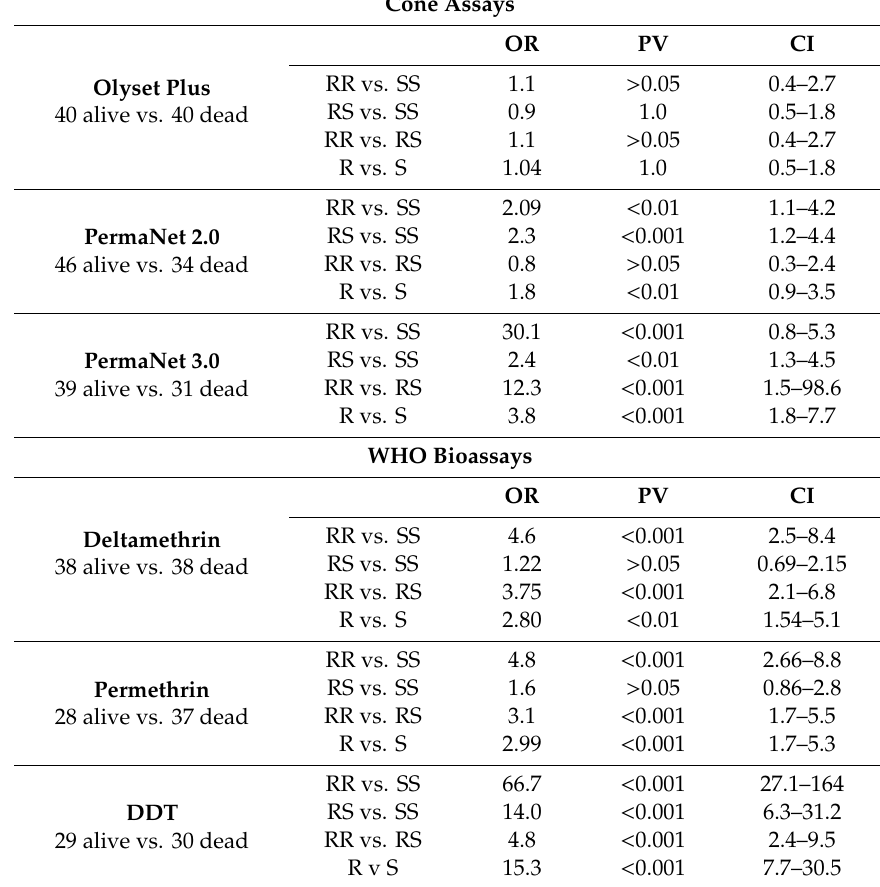
Table 7. Impact of GSTe2 on the ability of field population An. funestus to survive using samples from cone